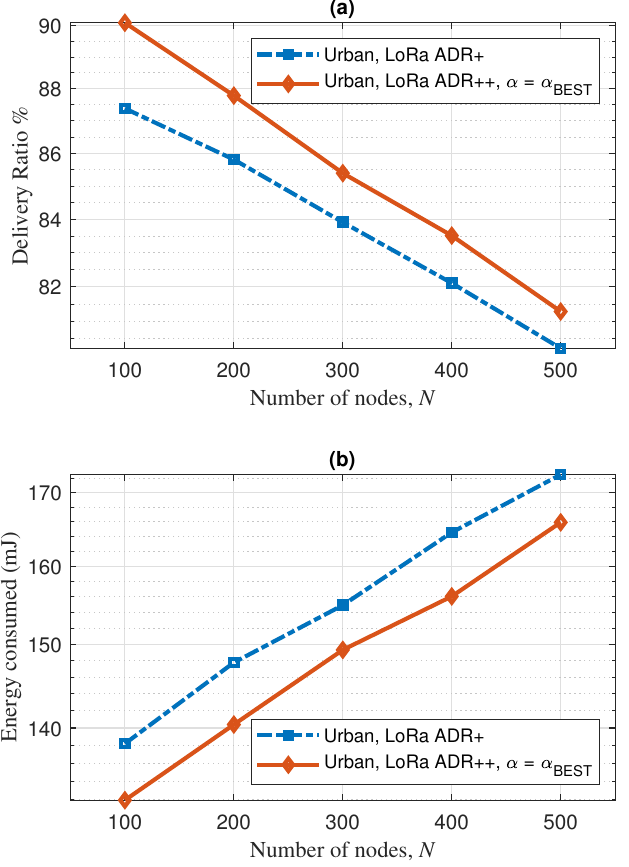
Figure 3. Simulation comparison between ADR+ and ADR++ at α BEST with different number of nodes in urban scenario: ( a ) delivery ratio; ( b ) energy consumed.